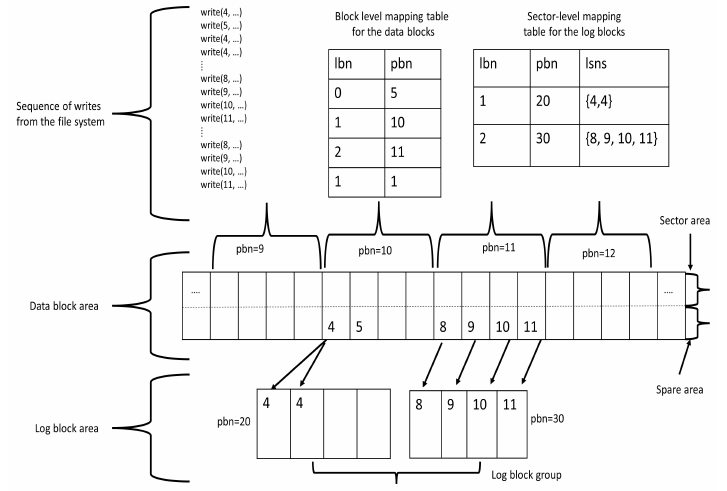
Figure 3. Processing of the write operation in the BAST